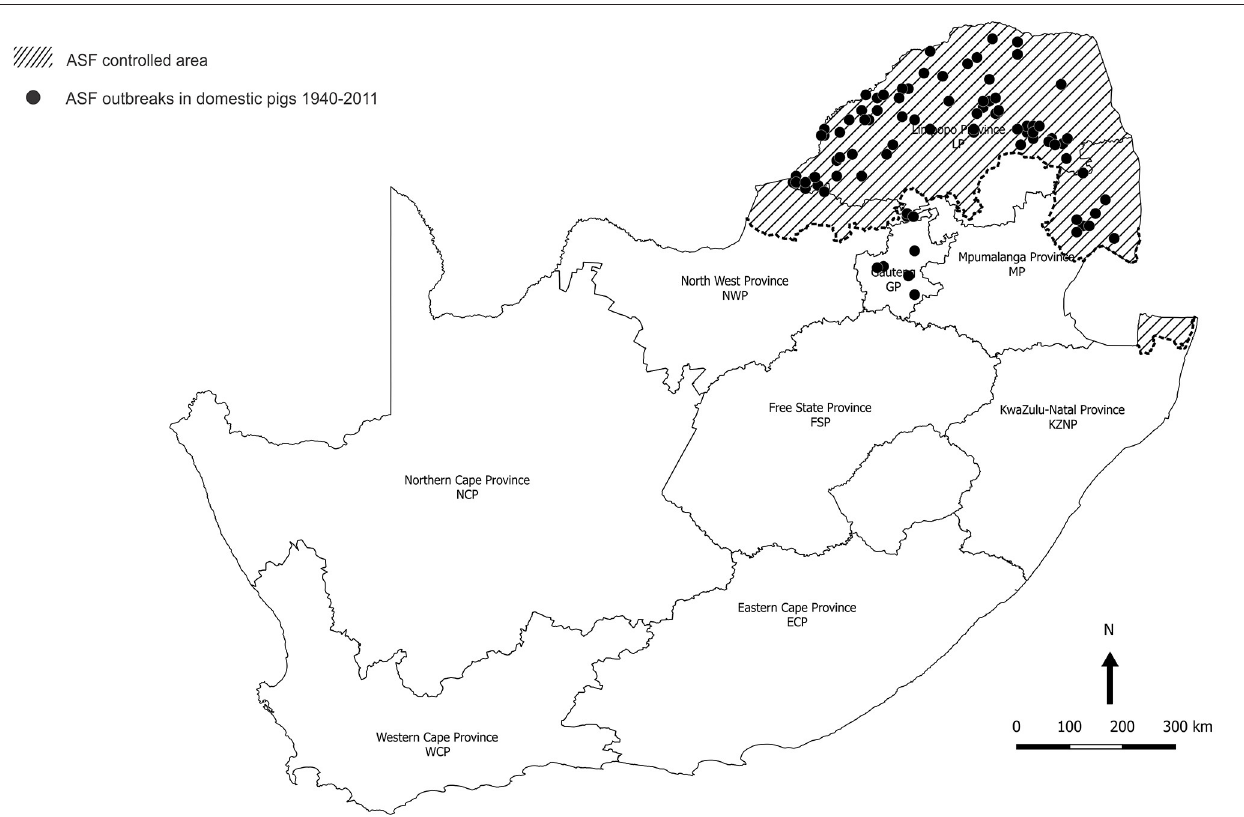
FIGURE 2 | Distribution of 89 outbreaks of African swine fever in South Africa, 1940–2011, for which approximate coordinates (correct to 0.1 degree) were derived from references cited in the text.